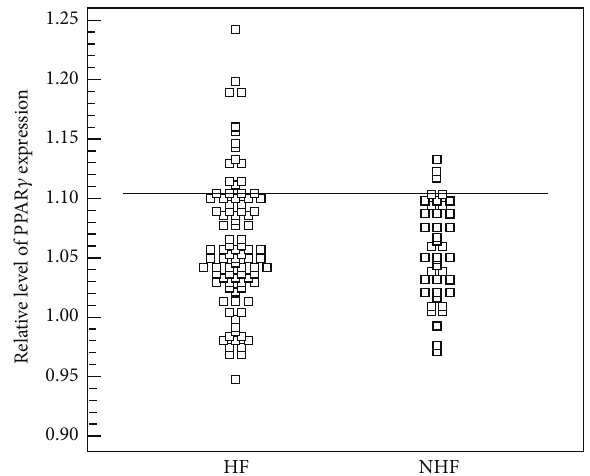
Figure 1: Level of expression of PPAR 𝛾 in aorta in the group with heart failure (HF) and without heart failure (NHF).